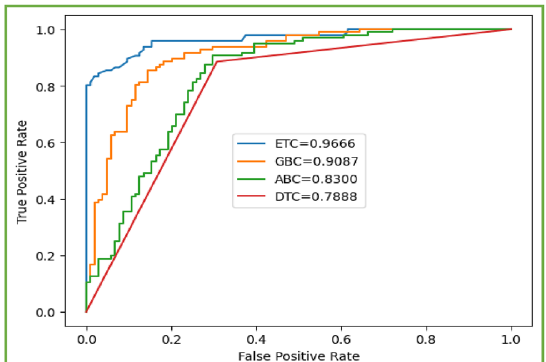
Fig. 2 The ROC plot of all classifiers for the PIMA dataset